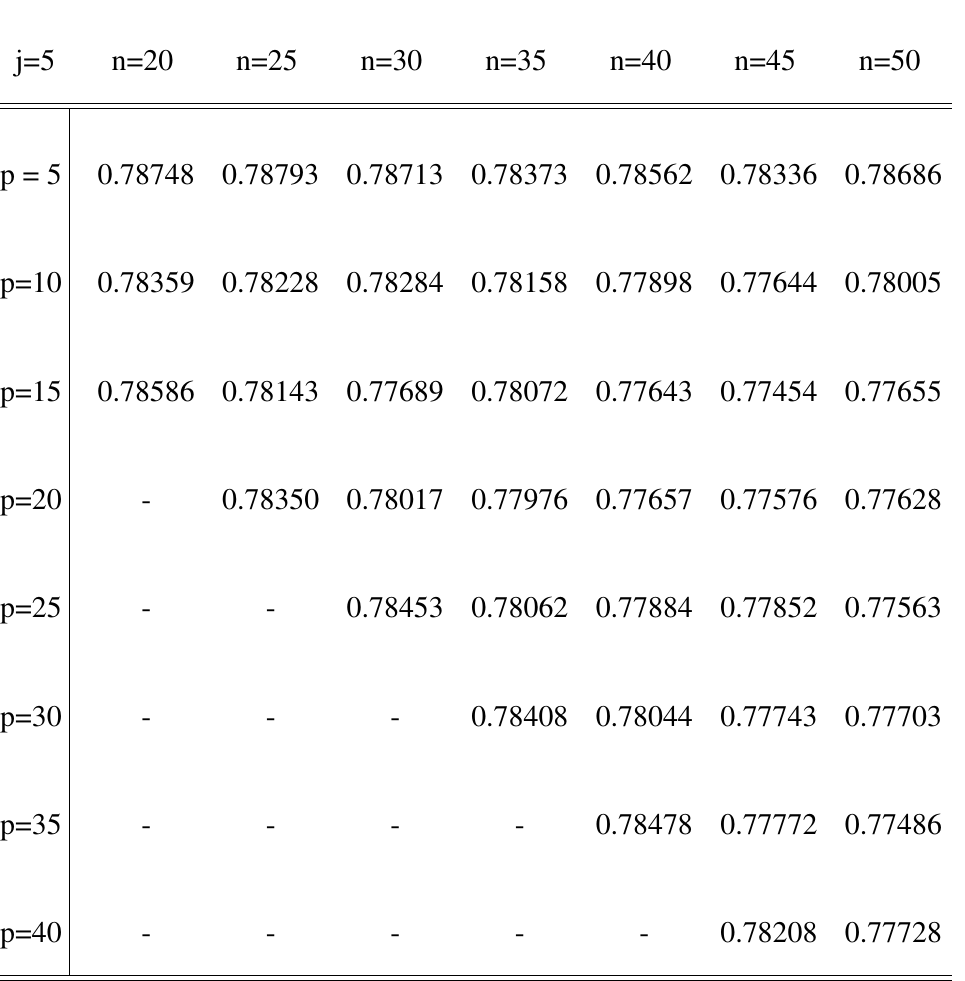
Table 4: Average Value of Dominance for different values of n and p for j = 5 sigma = 1